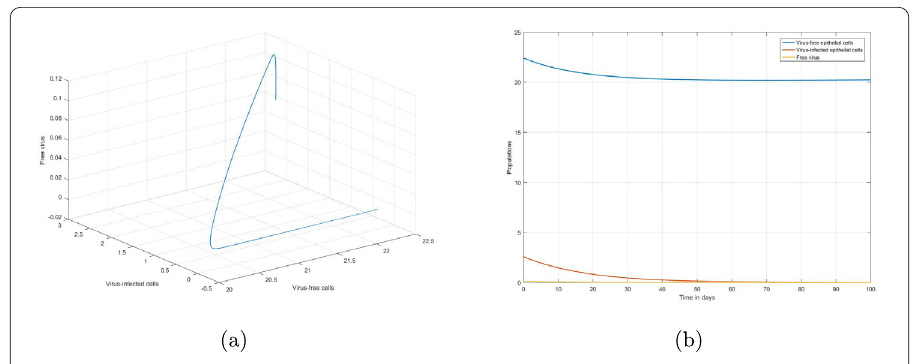
Figure 2 Dynamics of the numbers of virus-free epithelial cells, virus-infected epithelial cells, and SARS-CoV-2 virus when χ 0 <